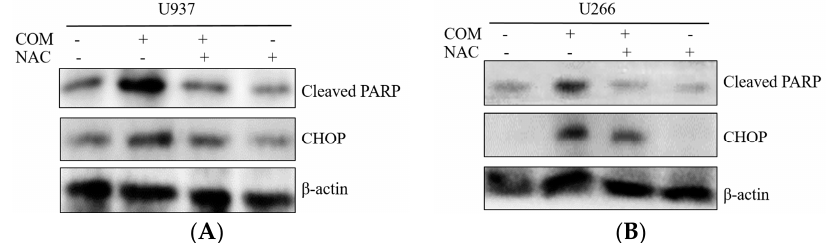
Figure 6. The effect of ROS scavenger on COM-induced PARP cleavage and CHOP activation in U937 and U266 cells. ( A ) U937 cells were treated with COM (80 µg/mL) for 24 h with or without pre-treatment of NAC (5 mM) for 1 h. Cell lysates were prepared and subjected to Western blot analysis for cleaved PARP and CHOP; ( B ) U266 cells treated under the same conditions.